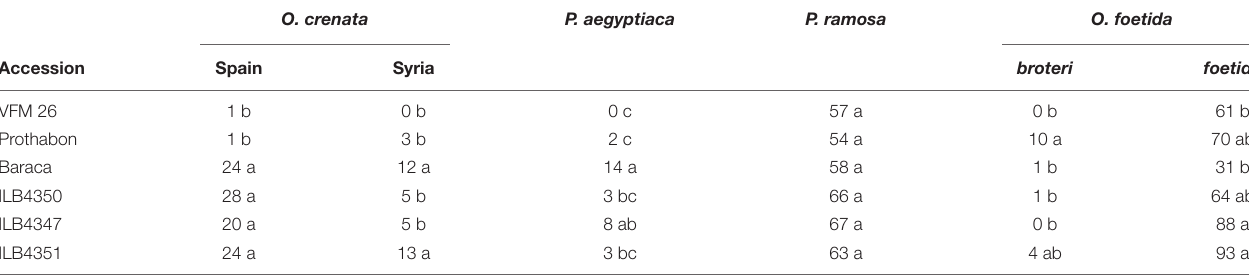
TABLE 5 | Percentage of broomrape radicles contacting faba bean roots that became necrotic.